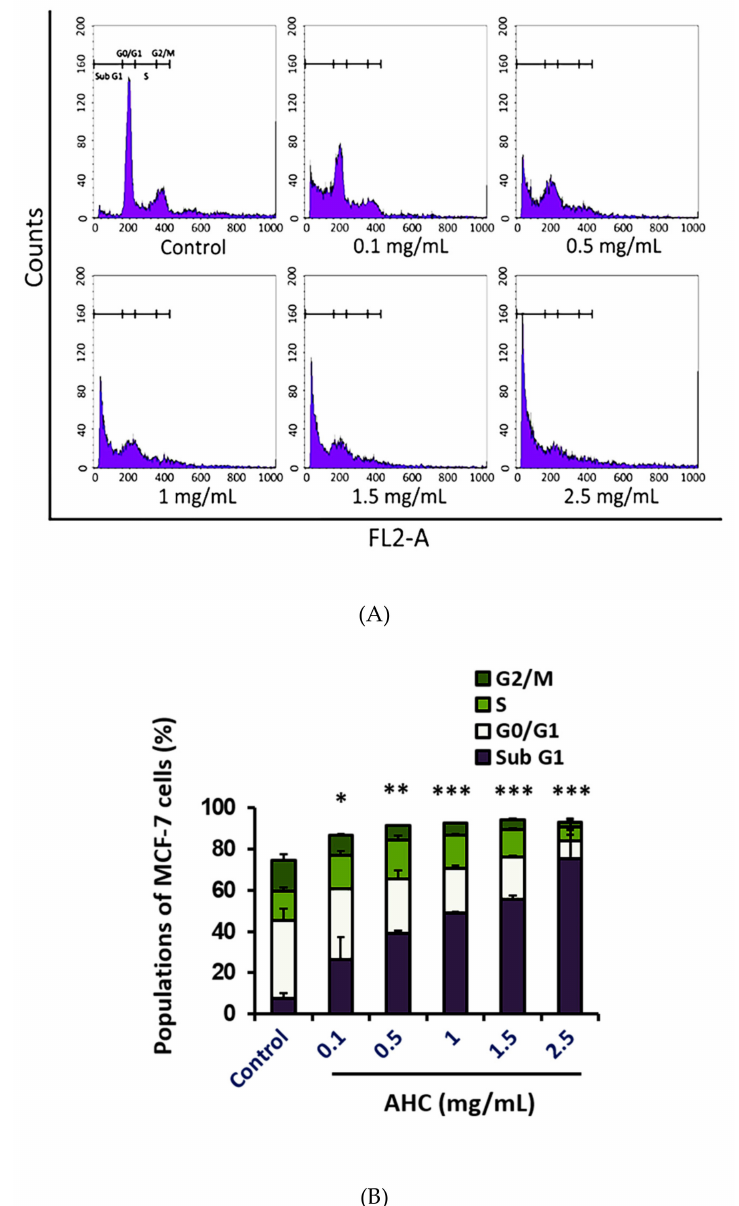
Figure 8. Cell cycle arrest e ff ect of the AHC extract against MCF-7 cells. ( A ) Histograms of cell cycle distribution ( B ) Diagram of each cell phase distribution. Histogram of DNA contents after 24 h treatment monitored by flow cytometry was presented. Control: 0.1% DMSO in culture medium. Data of * p < 0.5, ** p < 0.05, and *** p < 0.005 vs. Sub G1 phase of control. The fixed cells with lower DNA contents, the DNA-damaged cells including apoptotic or necrotic (cid:48) cells, can be distributed in the ‘Sub G1 phase when monitored [54]. Irreparable DNA damage may force the cancer cells to withdraw from the cell cycle so that they cannot replicate chromosomes. DNA damage prevents the cells from entering mitosis, the proliferative phase [55]. Increasing the concentration of AHC caused a raised population of MCF-7 cells in the Sub G1 phase, which was accompanied by a proportional decrease of the cells in the G0 / G1-S-G2 / M phases. Treatment of high concentrations of AHC for 24 h shifted the majority of the cells into Sub G1 phase compared to the control cells, which indicates the apoptosis induced by AHC. Our study displayed that inducing the cycle arrest in MCF-7 cells was an important basis of anti-proliferative activity of the AHC extract as